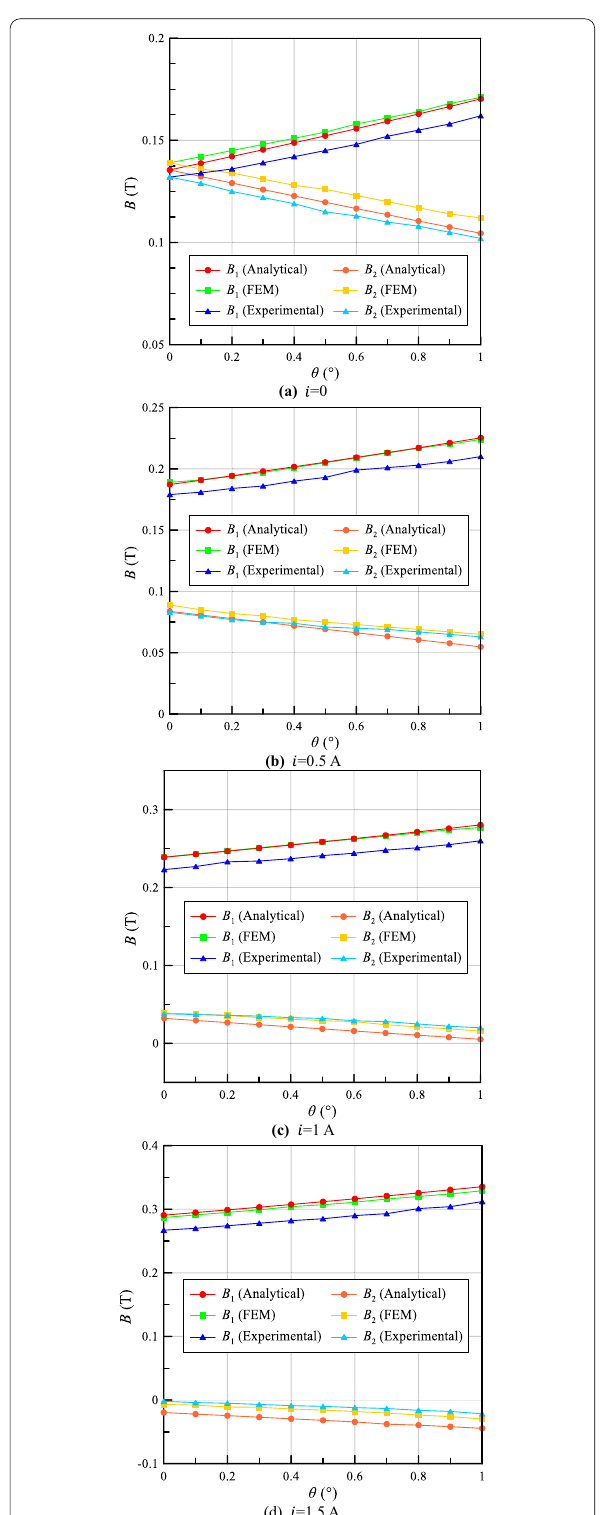
Figure 22 Magnetic flux densities under different currents and rotation